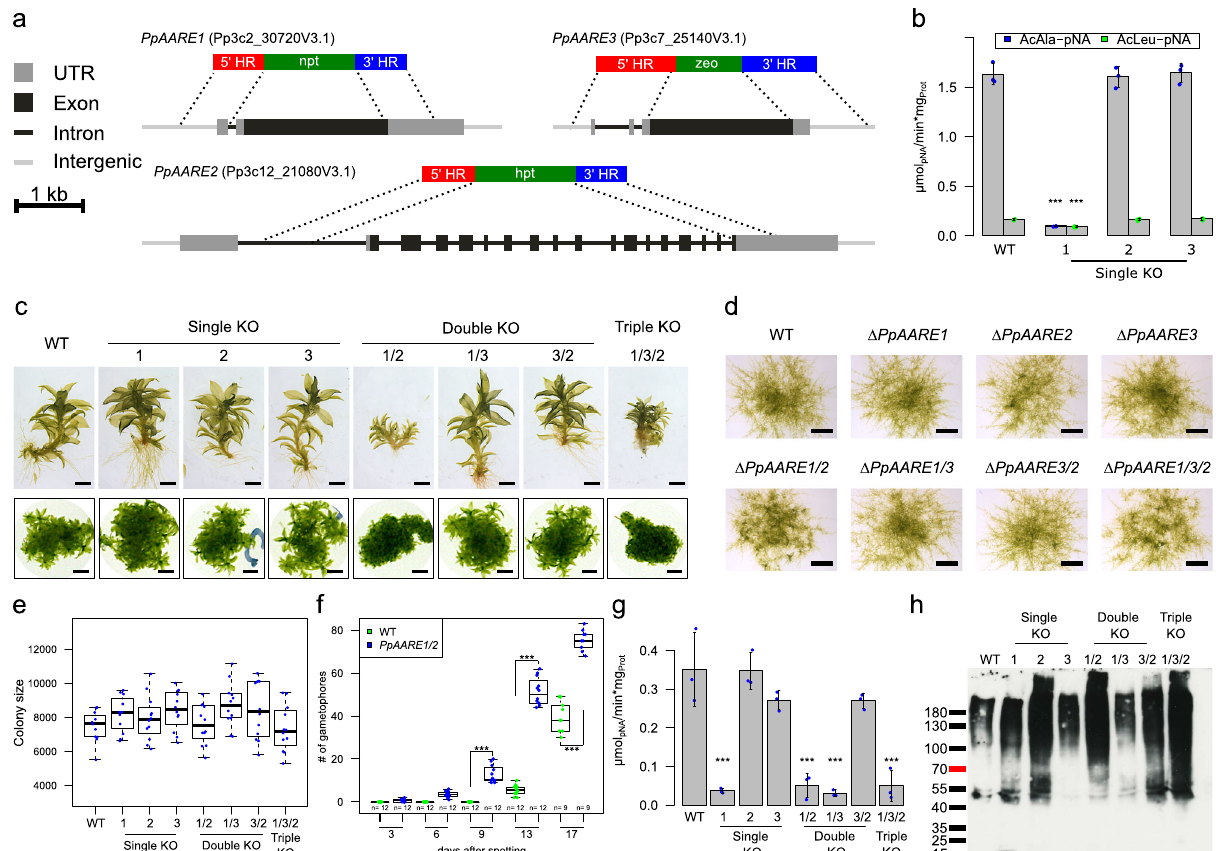
Fig. 3 Phenotype analyses, AARE activity and level of oxidized proteins in Physcomitrella WT and KO mutants. a Each isoform was knocked out using a different selection marker. The selection markers confer resistance against G418 (npt), hygromycin (hpt) and zeocin (zeo), respectively. Homologous regions (HR) were chosen in order to remove the full CDS of the corresponding gene upon integration of the selection marker. b Mean AARE activity on AcAla-pNA in Physcomitrella protonema with standard deviation ( n = three biological replicates). Signi fi cance levels are based on a one-way Anova and subsequent post-hoc test (*** p < 0.001) and indicate differences compared to WT. c Phenotypes of gametophores of WT and the different KOs cultivated on KnopME for 4 months. All colonies were grown on the same plate. Upper panel: Bar = 0.5 mm; lower panel: Bar = 2 mm. d Protonema colonies grown on KnopME with 0.02% glucose taken from suspension culture. Bar = 1 mm. Images were taken 9 days after spotting. e Box plot showing the distribution of colony areas ( n = 12 colonies per box plot; colony images taken 7 days after spotting). No signi fi cant difference of colony areas between WT and the KOs was observed (tested via one-way Anova). f Box plot showing the number of gametophores per colony and day of WT and Δ PpAARE1/2 . Counting was performed at indicated days after spotting protonema suspension culture on solid medium (KnopME with 0.02% glucose). Indicated signi fi cance levels are based on a two-way Anova with subsequent post-hoc test (*** p < 0.001). The box plots ( e , f ) depict the mean (horizontal bold line) of the data, the interquartile range (box) and the 1.5x interquartile range (whiskers). g Mean AARE exopeptidase activity on AcAla-pNA in gametophores. Depicted is the mean of three independent colonies per line with standard deviations. All colonies were cultivated on the same plate (Fig. S7a). Signi fi cance levels are based on one-way Anova and indicate differences compared to WT (*** p < 0.001). h Levels of oxidized proteins in gametophores of WT and the different KOs (Coomassie-stained loading control is shown in Fig. S7b). The analysis was repeated three times (additional blots available in Fig. S7c, d). Detection